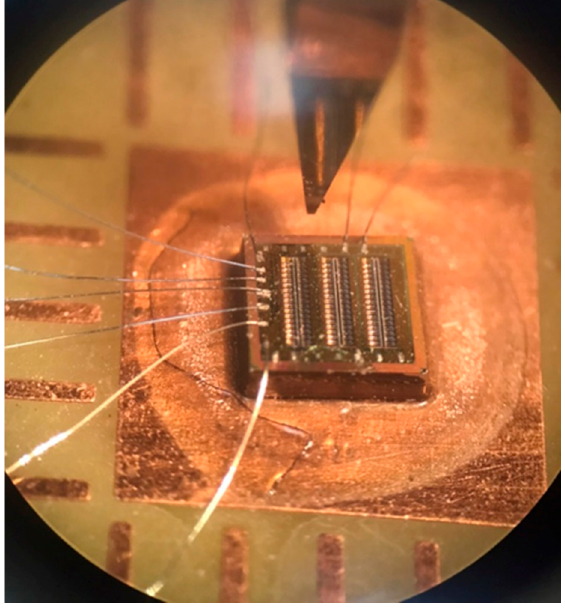
Figure 14. Wire bonding for the